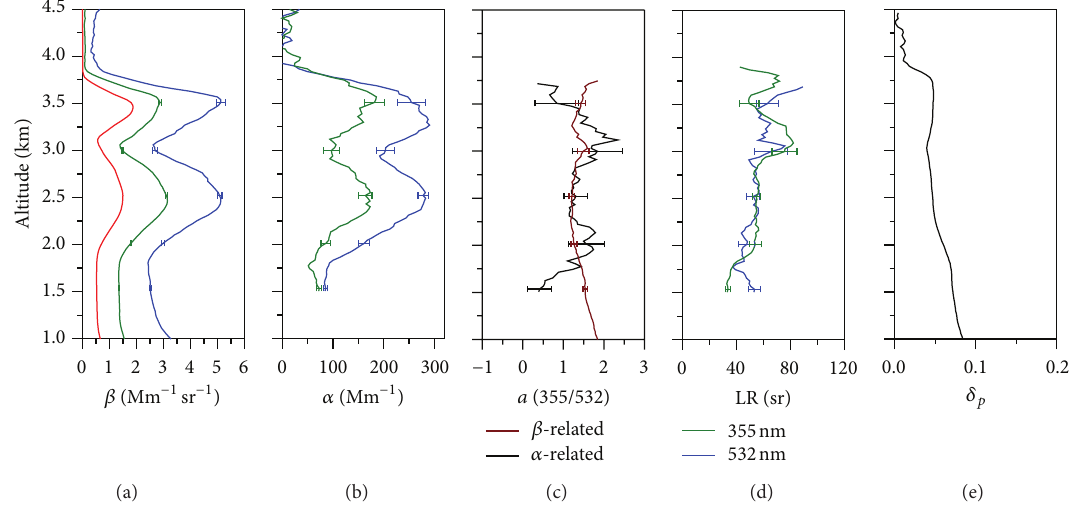
Figure 5: Profiles of (a) backscatter coefficients (355-blue, 532-green, and 1064 nm-red), (b) extinction coefficients (355-blue and 532 nm- green), (c) backscatter and extinction-related ˚Angstr¨om exponent (wavelength pair 355/532 nm), (d) lidar ratios (355 and 532 nm), and (e) particle linear depolarization ratio (532 nm) measured on 18 October 2010 21:45–22:15